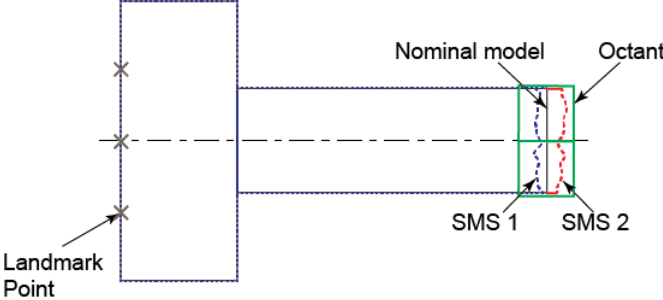
Figure 4. Superimposed two SMSs and a nominal model registered at landmarks, creating parametric SMS.